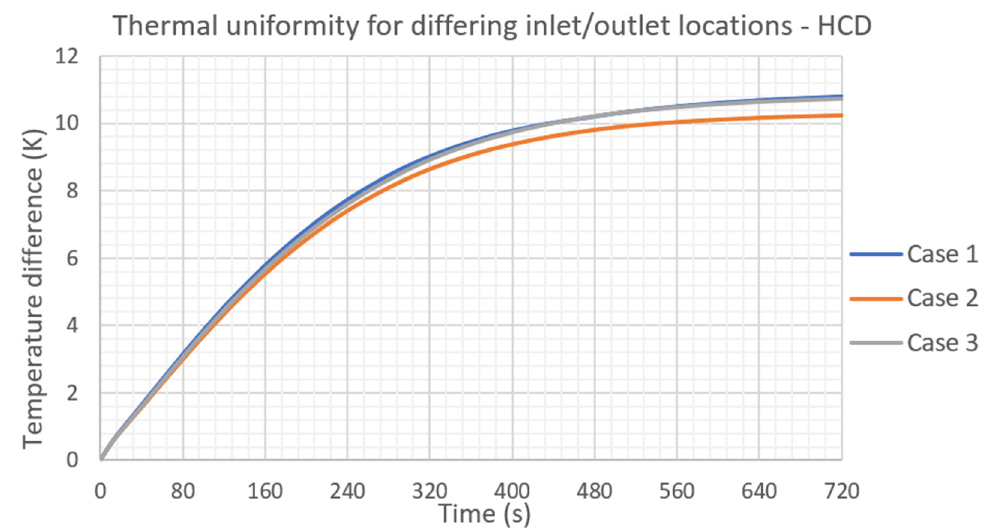
Figure 16. Cell temperature difference over discharge cycle for differing inlet/outlet locations–HCD.